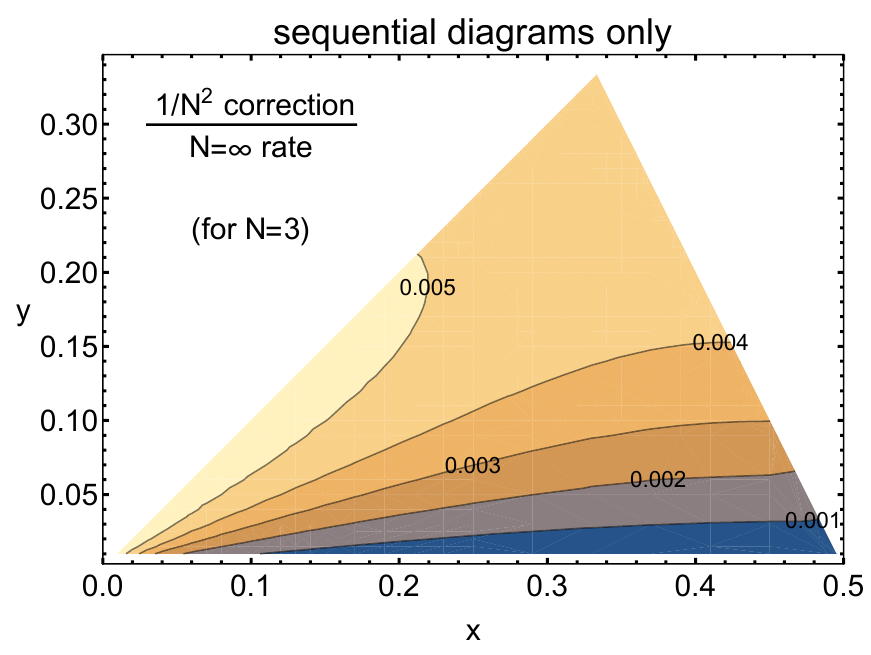
Figure 16 . Like figure 15 except now for sequential diagrams instead of crossed diagrams.